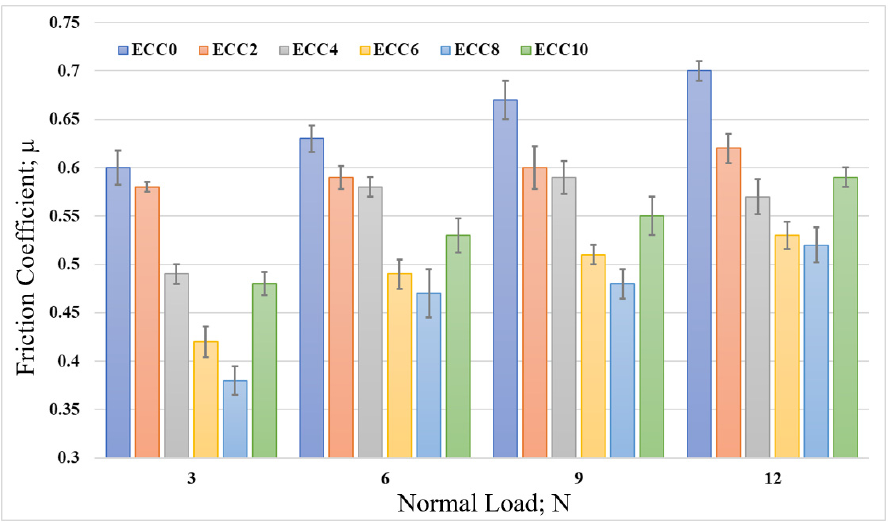
Figure 7. The friction coefficient of epoxy/corn cob composites under different normal loads.